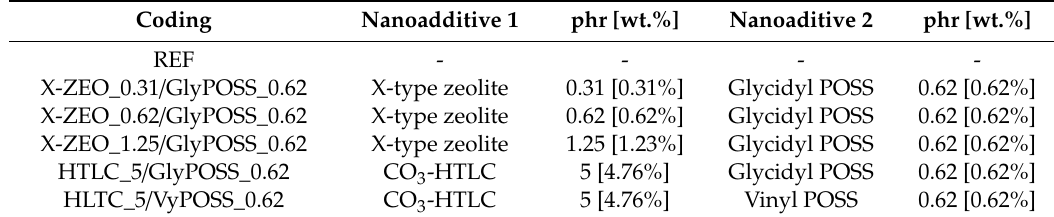
Table 3. Formulations with two